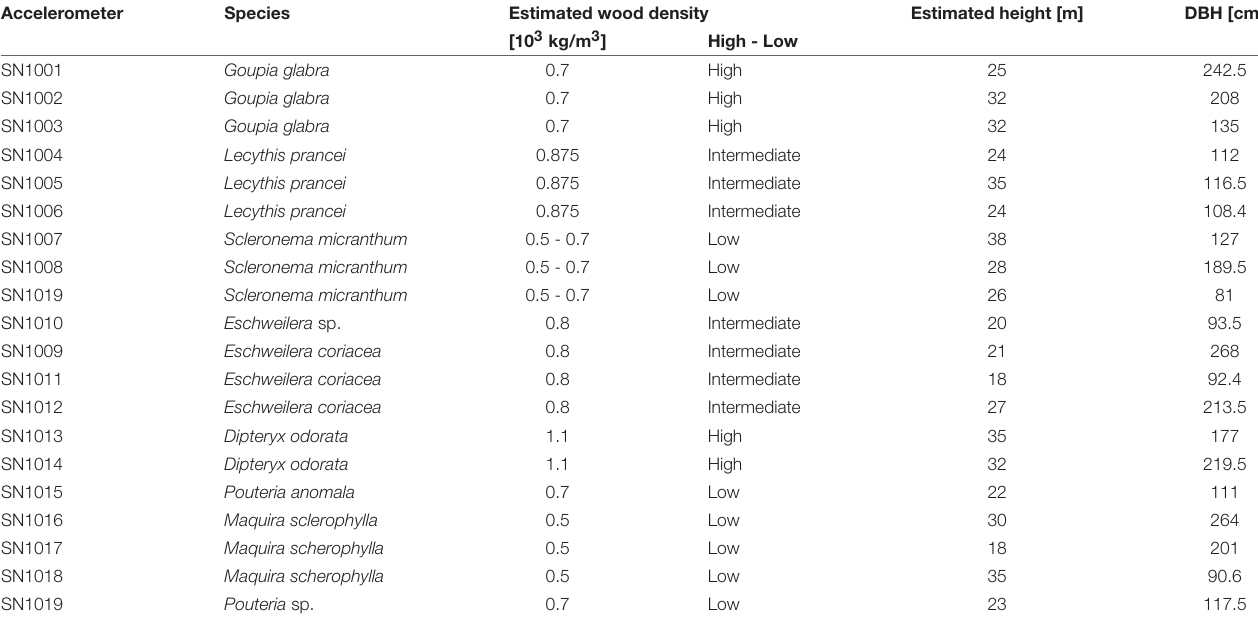
TABLE 1 | List of measured tree individuals, including acceleration sensor number, estimated wood density, estimated tree height and diameter at breast height (DBH). Accelerometer Species Estimated wood density Estimated height